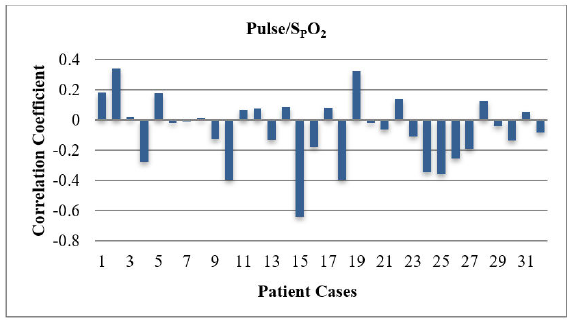
Figure 4. Correlation Results of Vital Signs for Sleep Apnea correlation, 10 cases (31%) have positive